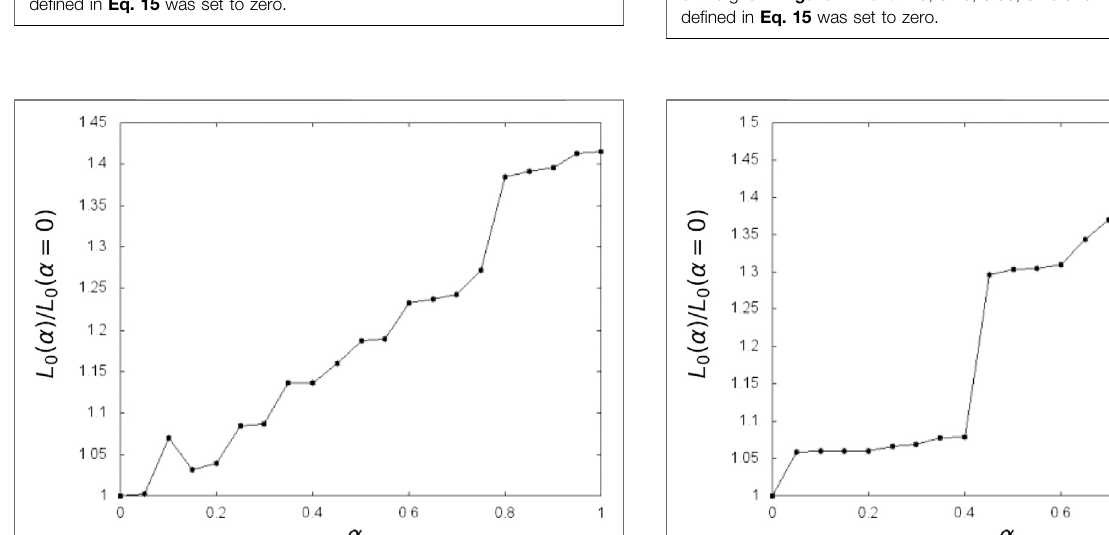
FIGURE 5 | Optimal paths between the lower left and upper right corner of the grid in Figure 2B for α (cid:3) 0, 0.25, 0.50, 0.75 and 1. The parameter β , de fi ned in Eq. 15 was set to zero.